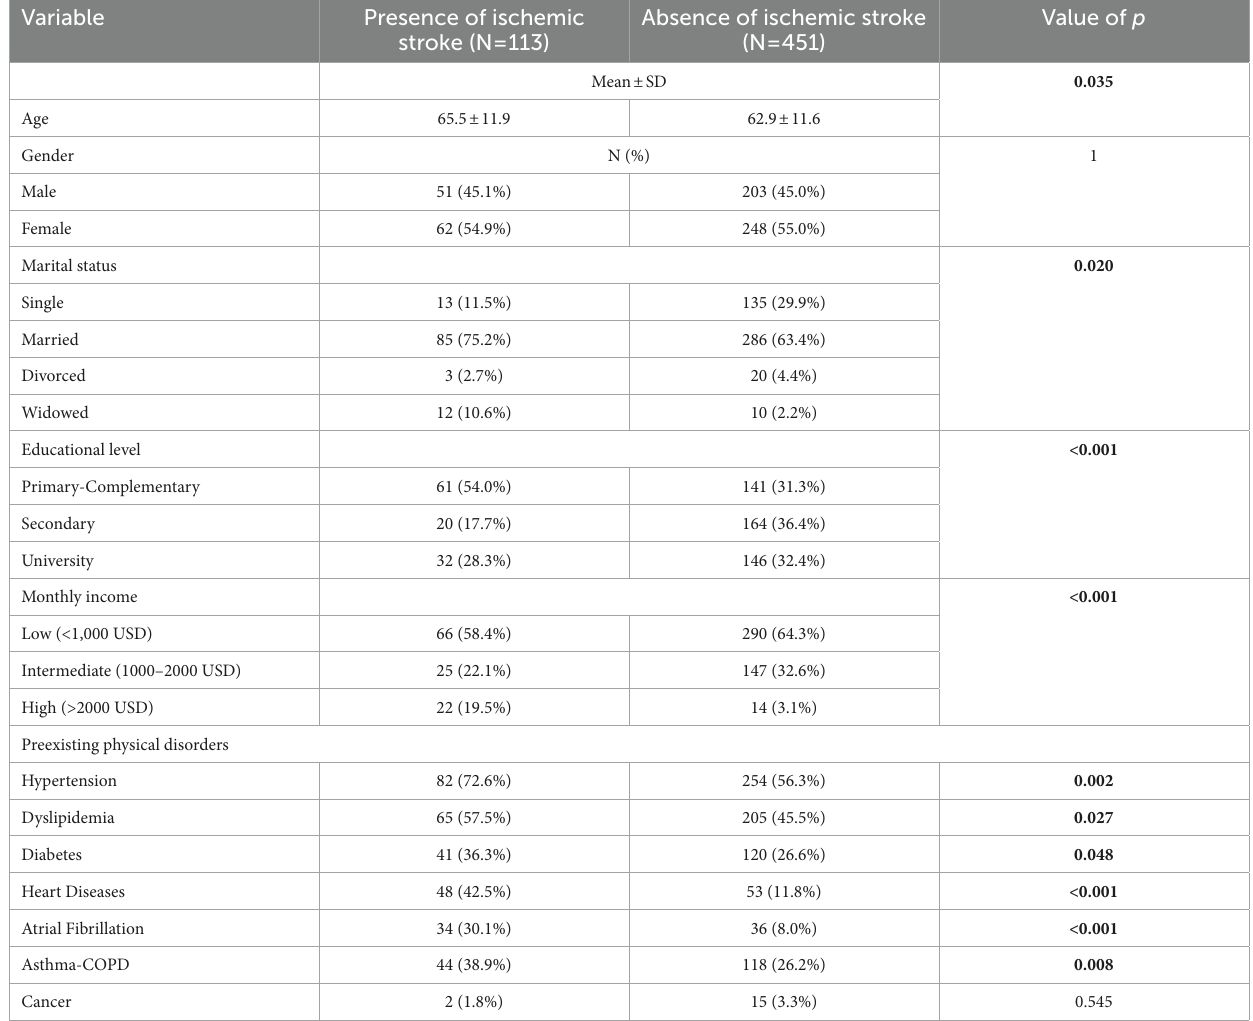
TABLE 1 Bivariate analysis of demographic factors associated with ischemic